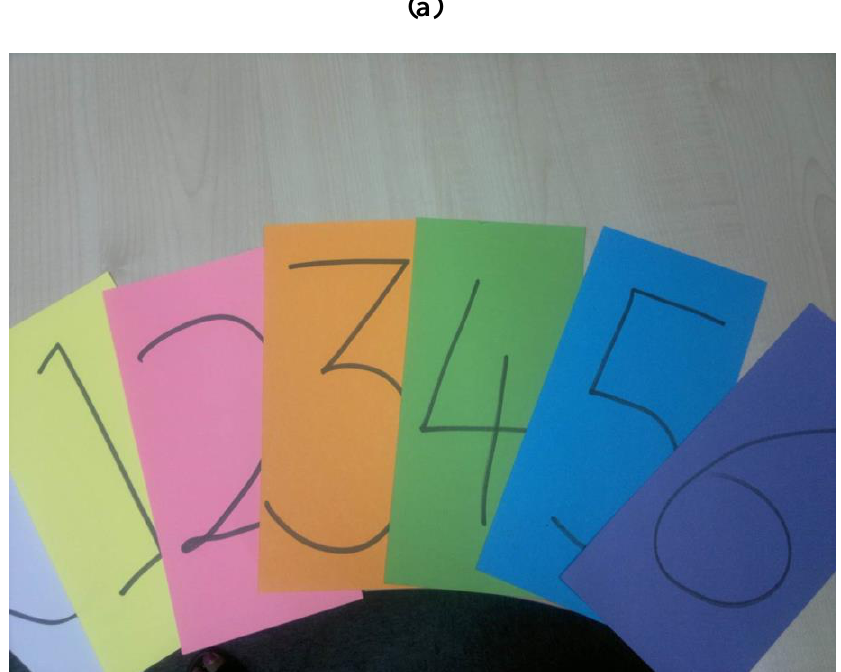
Figure 5. Different colored cards depicting the ICDAS codes used for photograph discussion exercise by the trainees (a) . Form used by the ICDAS trainees in the extracted teeth exercise (b) . Venue set-up for the ICDAS workshop (c)